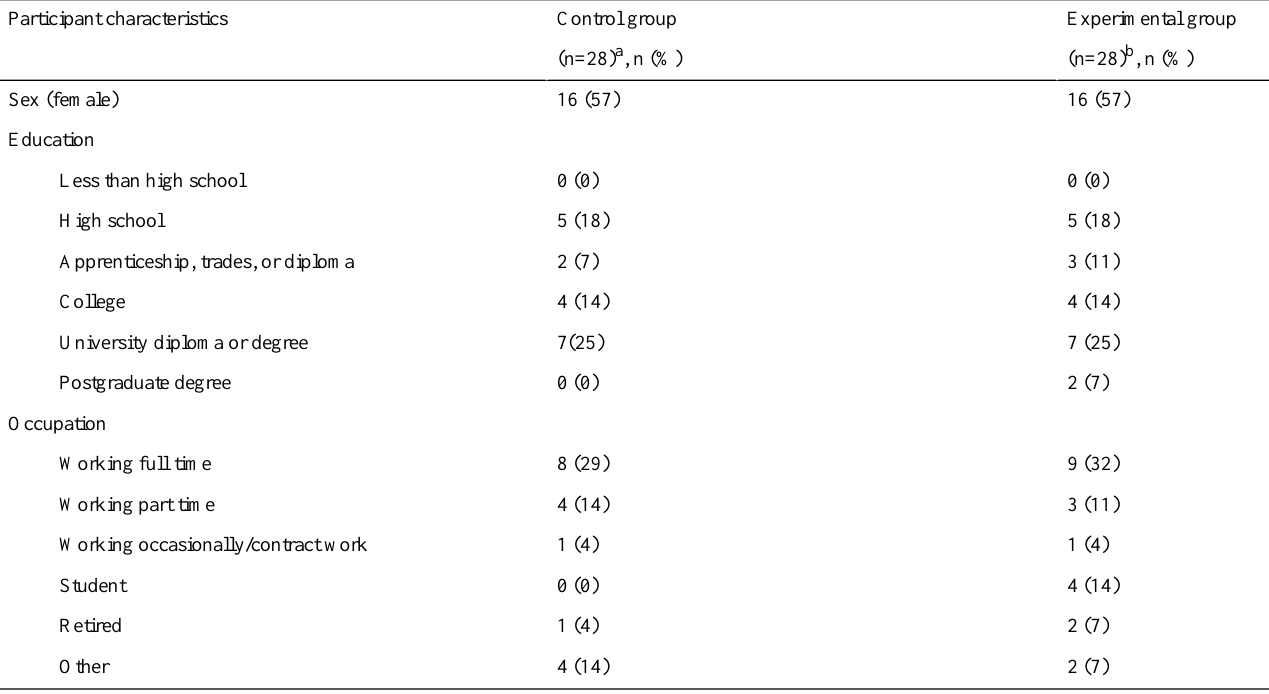
Table 4. Participant demographic characteristics.